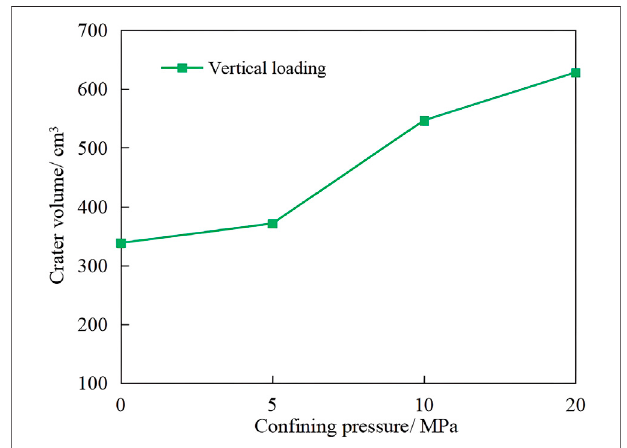
FIGURE 8 | Crater volume.